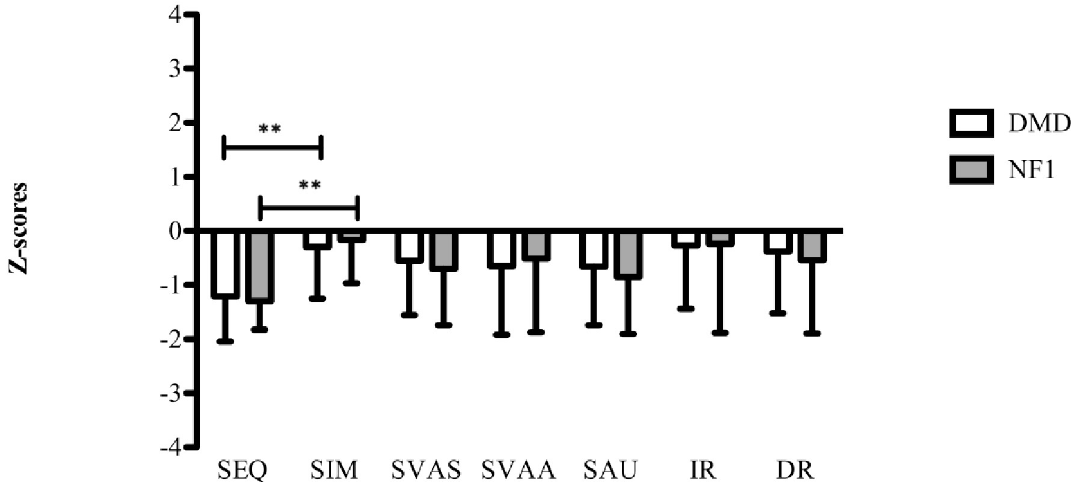
Fig 3. Mean (SD) outcomes of z-scores of the DMD group (N = 38) and NF1 (N = 38) group. SEQ = Sequential processing, SIM = Simultaneous processing, SVAS = Sustained Visual Attention Speed, SVAA = Sustained Visual Attention Accuracy, SAU = Sustained Auditory Attention, IR = immediate recall, DR = delayed recall, DMD = Duchenne muscular dystrophy, NF1 = Neurofibromatosis type 1. �� p < .001 (two-sided). The outcomes are frequencies of the mean outcomes. The statistical method used to compare the outcomes of KABC SEQ processing and SIM processing within the DMD or NF1 group was the paired sample t- test. The z-scores represent the mean outcomes and standard deviations on cognitive outcomes of each